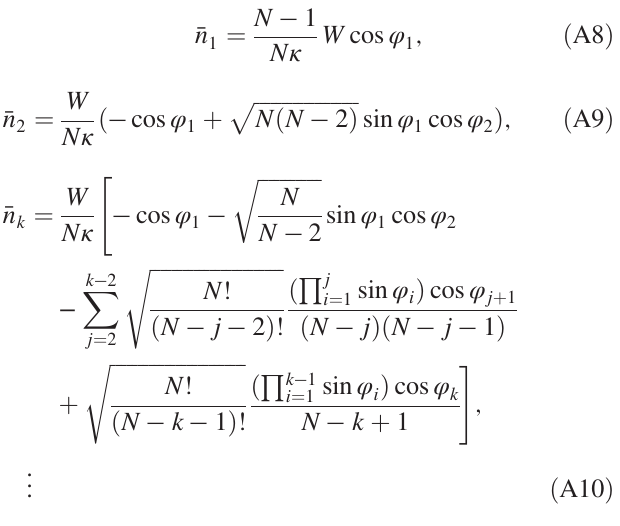
ffiffiffiffiffiffiffiffiffiffiffiffiffiffiffiffiffiffiffi N ð N − 2 Þ